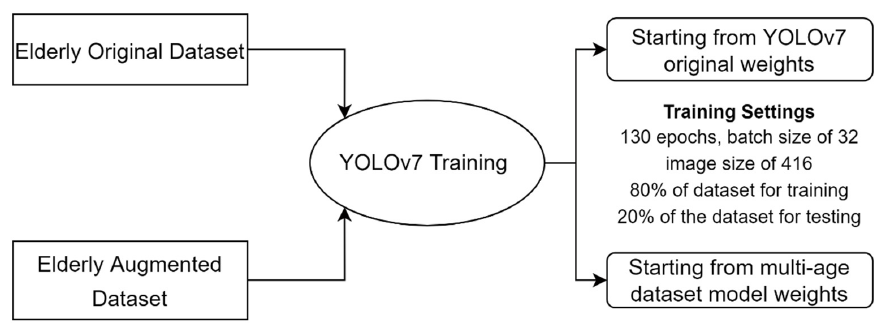
Figure 11. Training of elderly original and augmented datasets using YOLOv7 original weights and YOLOv7 multi-age dataset model weights.